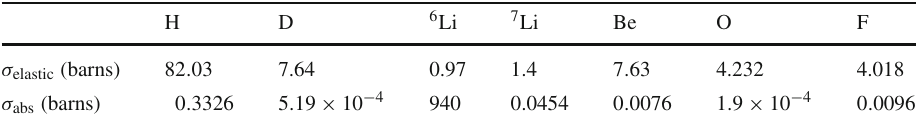
Table 1 Elastic scattering and absorption cross sections of various